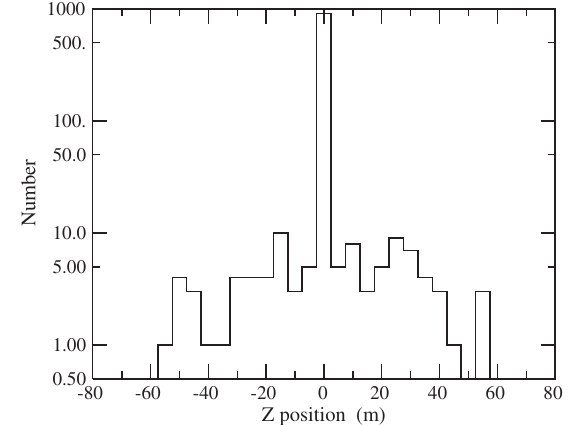
FIG. 18. Like Fig. 15 except for the cooled beam measure- ments of Fig.